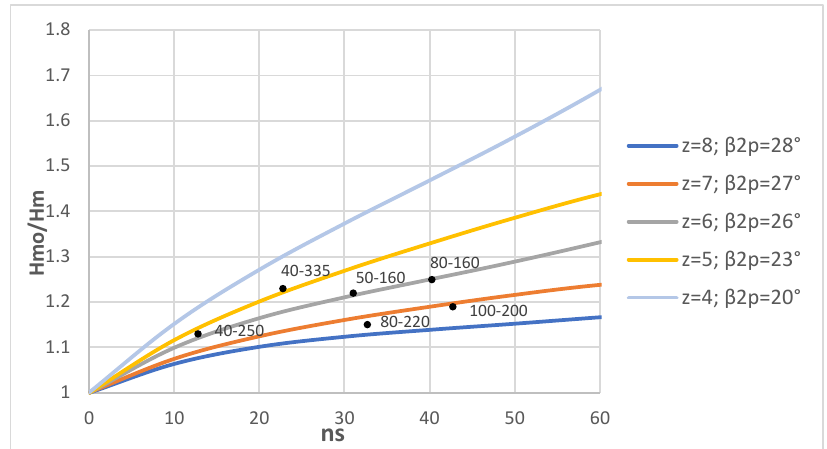
Figure 6. Statistical diagram for the determination of z and β 2p .